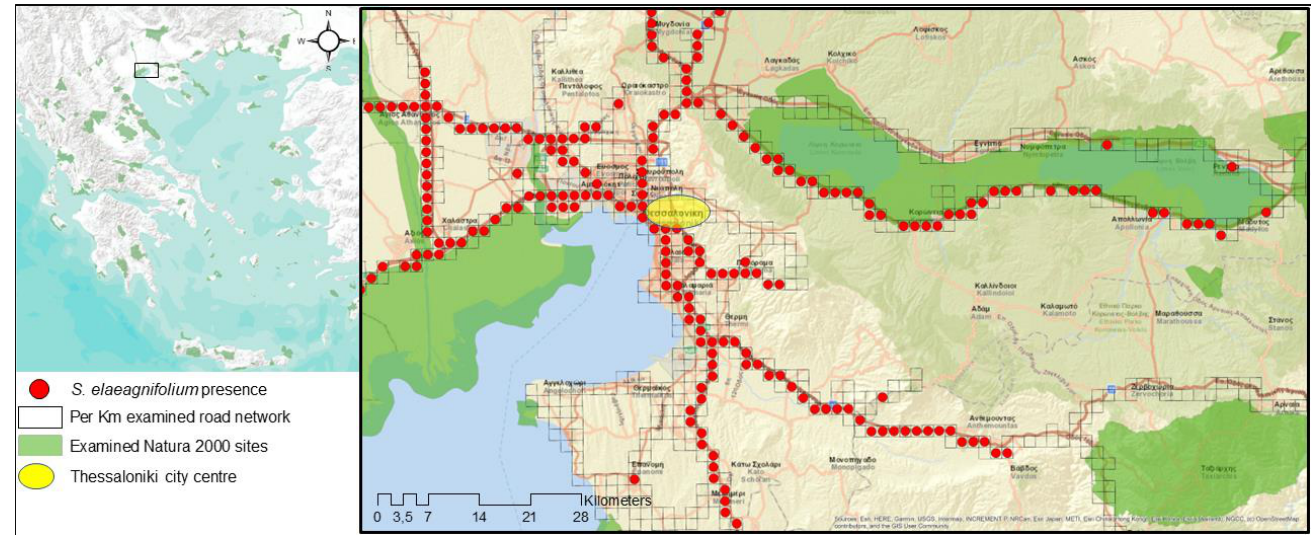
Figure 2. Examples of different routes (represented by squares of 1 km 2 ) followed to record the presence/absence data for Solanum elaeagnifolium , starting from the city center of Thessaloniki to destinations including the Natura 2000 sites (in green) .